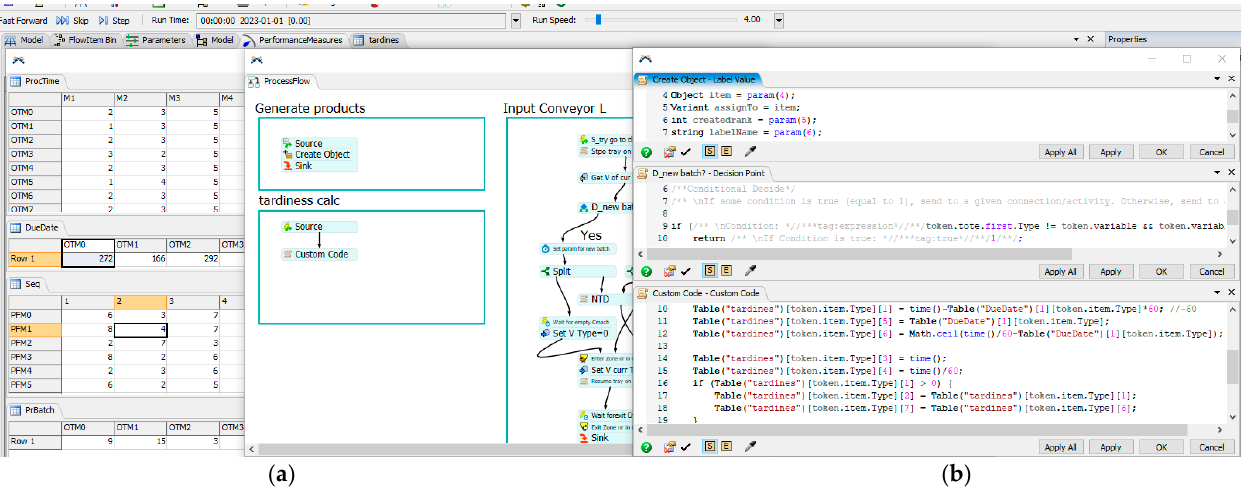
Figure 3 Integration modules directly in FlexSim. ( a ) data tables, ( b ) FlexScript modules Figure 3. Integration modules directly in FlexSim. ( a ) data tables, ( b ) FlexScript